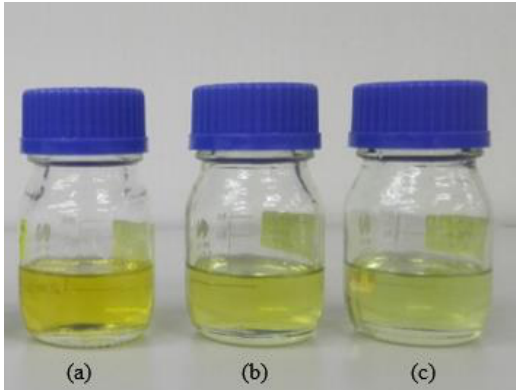
Figure 5. Appearance of hybrid biofuel after a month. ( a ) MCO25RPO75; ( b ) MCO50RPO50; ( c ) MCO75RPO25.